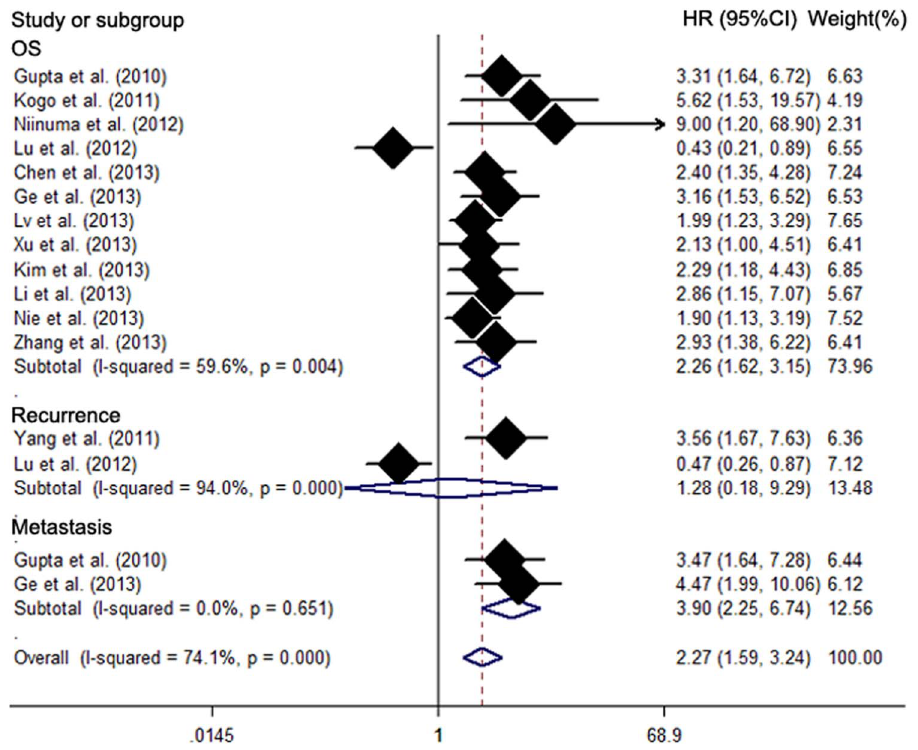
Figure 3. Meta analysis of the independent role of HOTAIR in OS/recurrence/metastasis of different types of cancer.